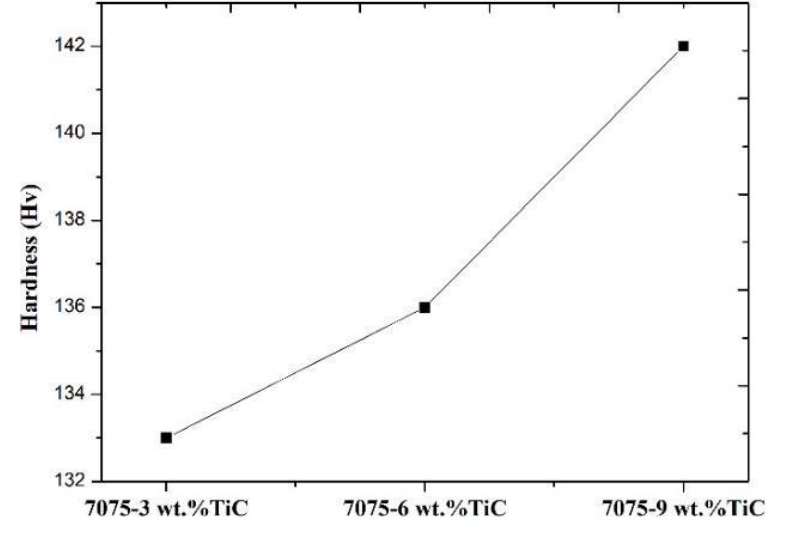
Fig. 7. Hardness behavior of composites.